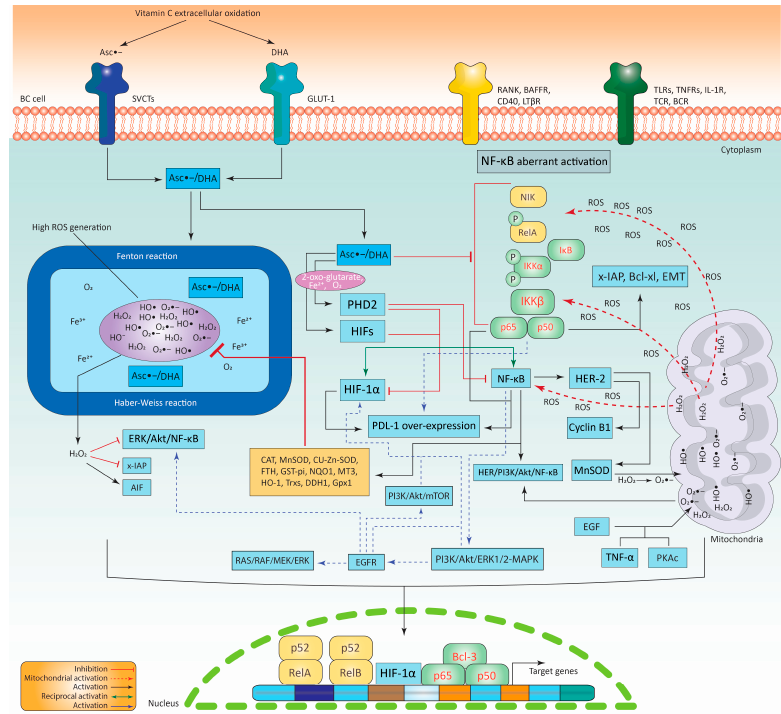
Figure 3. High-dose vitamin C targeting different pathways of the NF- κ B and HIF-1 α . The NF- κ B can take advantage of ROS generated by mitochondria to activate various genes such as HIF-1 α in favor of BC. Vitamin C, on the other hand, produces a high amount of ROS that can inhibit NF- κ B and its various subunits directly or indirectly. Vitamin C activates enzymes that are able to inhibit NF- κ B and HIF-1 α as well as their target genes. BC cell, breast cancer cell; TLRs, Toll-like receptors; TNFRs, TNF- α receptors; TCR, T cell receptor; BCR, B cell receptor; LT β R, lymphotoxin β receptor; BAFFR, the BAFF receptor; RANK, receptor activator of nuclear factor-kappa beta; PI3K, phosphoinositide 3-kinase; ERK, extracellular signal-related kinase; HER2, human epidermal growth factor receptor 2; NF- κ B, nuclear factor-kappa beta of activated B cell; NIK, NF- κ B-inducing kinase; PD-L1, programmed cell death receptor 1 ligand; PHD-2, prolyl hydroxylase-2; FIH, factor-inhibiting HIF-1 α ; SVCTs, sodium-dependent vitamin C transporters; GLUT-1, glucose transporter 1; Fe 3+ , ferric ion; Fe 2+ , ferrous ion; ROS, reactive oxygen species; DHA, de-hydroascorbic acid; Asc •− , ascorbic intermediate radical; PKAc, protein kinase; CAT, catalase; MnSOD, manganese superoxide dismutase; Gpx1, glutathione peroxidase-1; CU-Zn-SOD, copper–zinc superoxide dismutase; FTH, ferritin heavy chain; Trx, thioredoxin; GST-pi, glutathione S-transferase Pi; NQO1, NADPH-dehydrogenase- quinone-1; MT3, metallothionein-3; EGF, epidermal growth factor; x-IAP, X-linked inhibitor of apoptosis; AIF, mitochondrial flavoprotein. Note: For more information, please see the